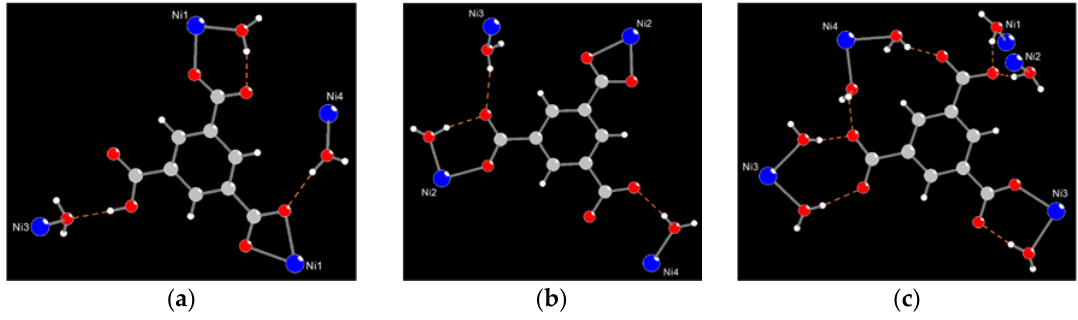
Figure 6. The proximity of intra- and inter-molecular hydrogen bonds between the carboxylate fragments of ( a ) Hbtc 2 − fragment in A ; ( b ) btc 3 − fragment in B ; ( c ) btc 3 − fragment in C respectively, and the coordinated water molecules.